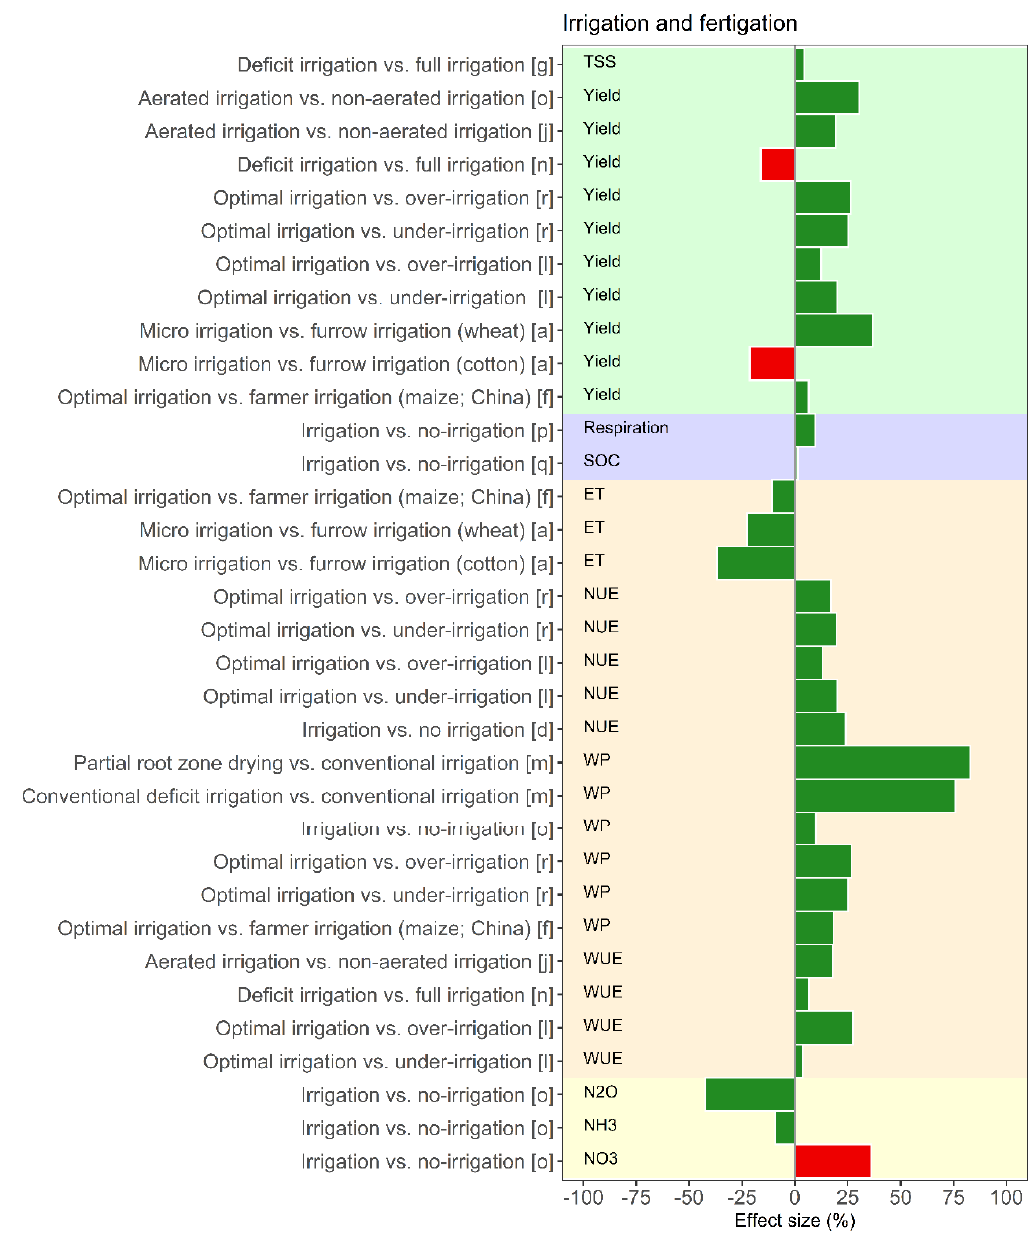
Figure 4. Overall response ratios reported in meta-analysis studies on irrigation and fertigation grouped per area of interest (light green: agronomic; light blue: soil quality; light orange: resource use efficiency; light brown: economic (no data); light yellow: environmental impacts). The management or treatment comparison is indicated outside the y-axis and the variable to which the data refer are listed inside the y-axis (abbreviations can be found in Table A1). Green bars indicate improvement, red bars indicate worsening. See also Table S3. [a]: [94]; [b]: [90]; [c]: [95]; [d]: [96]; [e]: [91]; [f]: [97]; [g]: [98]; [h]: [99]; [i]: [89]; [j]: [100]; [k]: [101]; [l]: [88]; [m]: [102]; [n]: [103]; [o]: [104]; [p]: [92]; [q]: [93]; [r]: